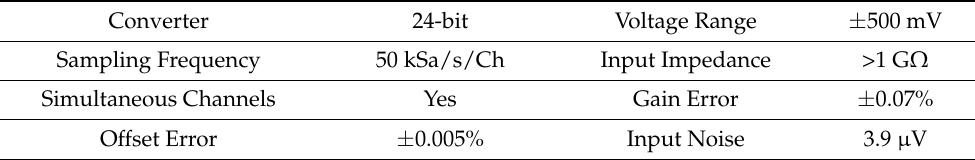
Table 1. Main characteristics of the NI9238.